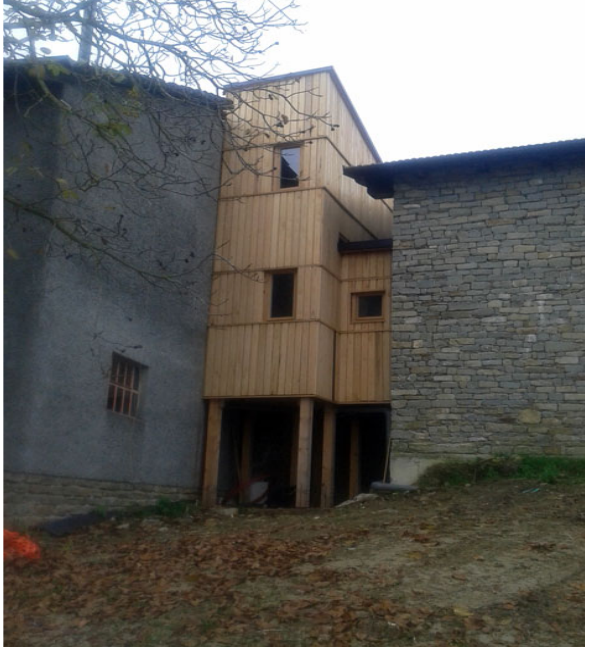
Figure 5. New wooden enlargement of the